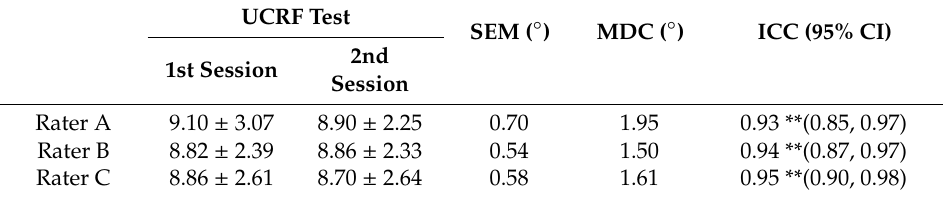
Figure 4. ( a ) Scatterplot showing the relationship between the upper cervical flexion angle using X-ray and the upper cervical rotation-flexion test (UCRF); ( b ) scatterplot showing the relationship between the upper cervical flexion-extension (UCFE) and UCRF tests. Table 2. Intra-rater reliability for upper cervical rotation-flexion test.